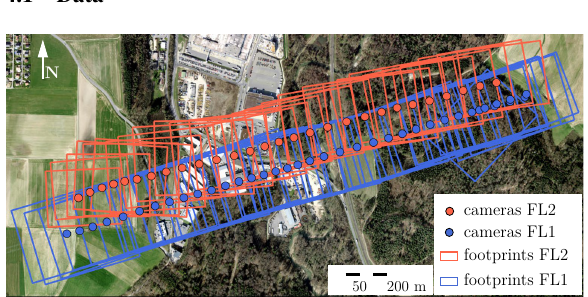
Figure 3. Overview of the study area and the image footprints for the flight lines (FL) studied. Both urban and rural areas are enclosed in the mapping